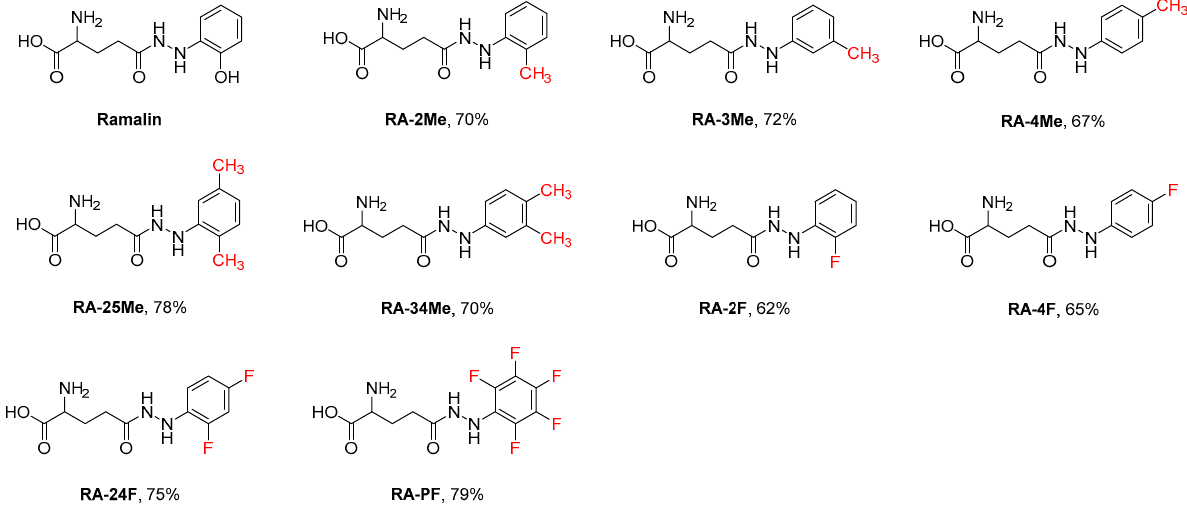
Figure 1. Structure of ramalin and its derivatives.